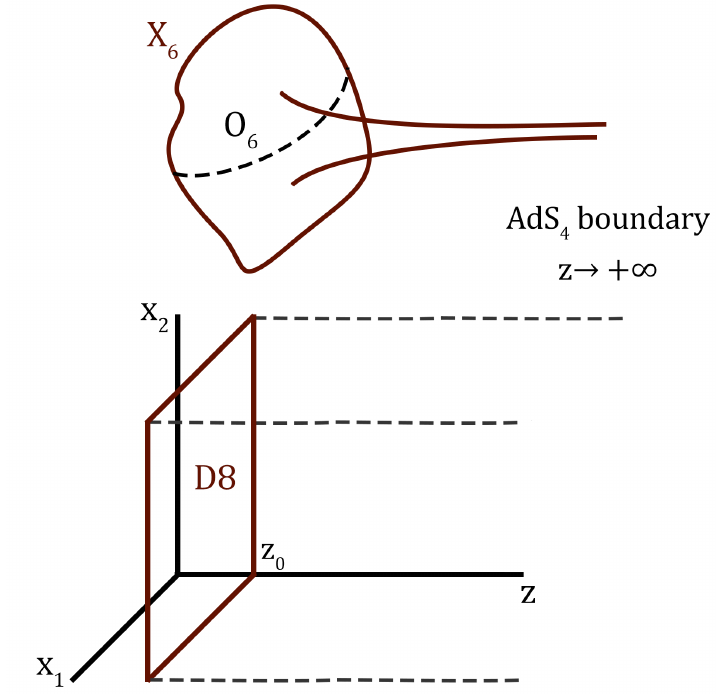
Figure 2 . Beyond the smearing approximation, the D8/D6 system of figure 1 becomes a BIon-like solution for the D8-brane, with a BIon profile that peaks at the O6-plane